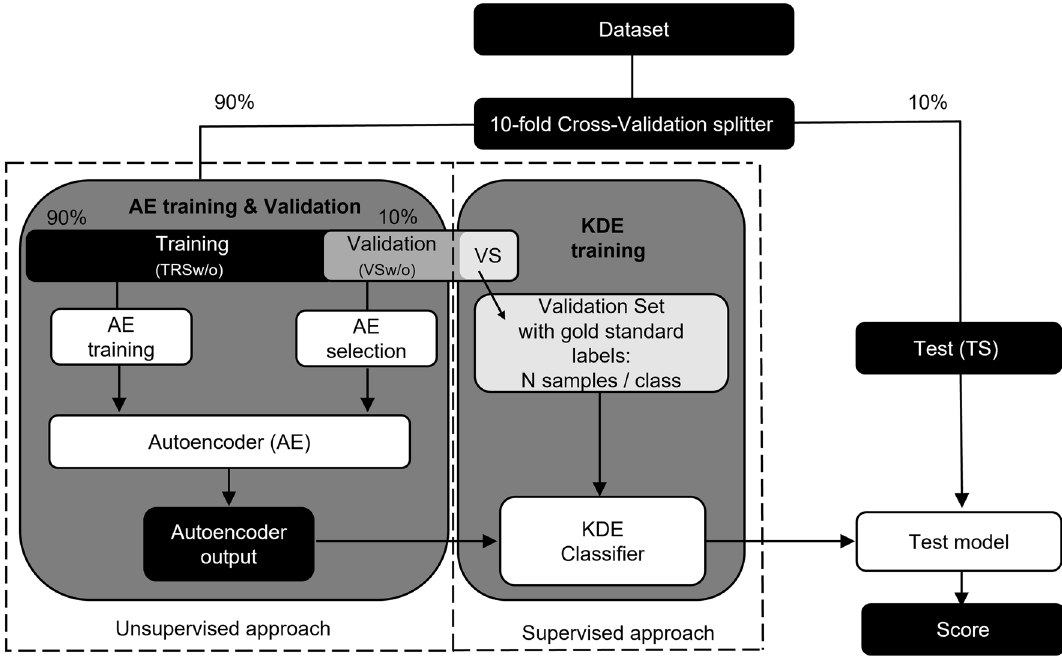
Figure 4. Model training, validation and testing pipeline. The model was tested using tenfold cross-validation